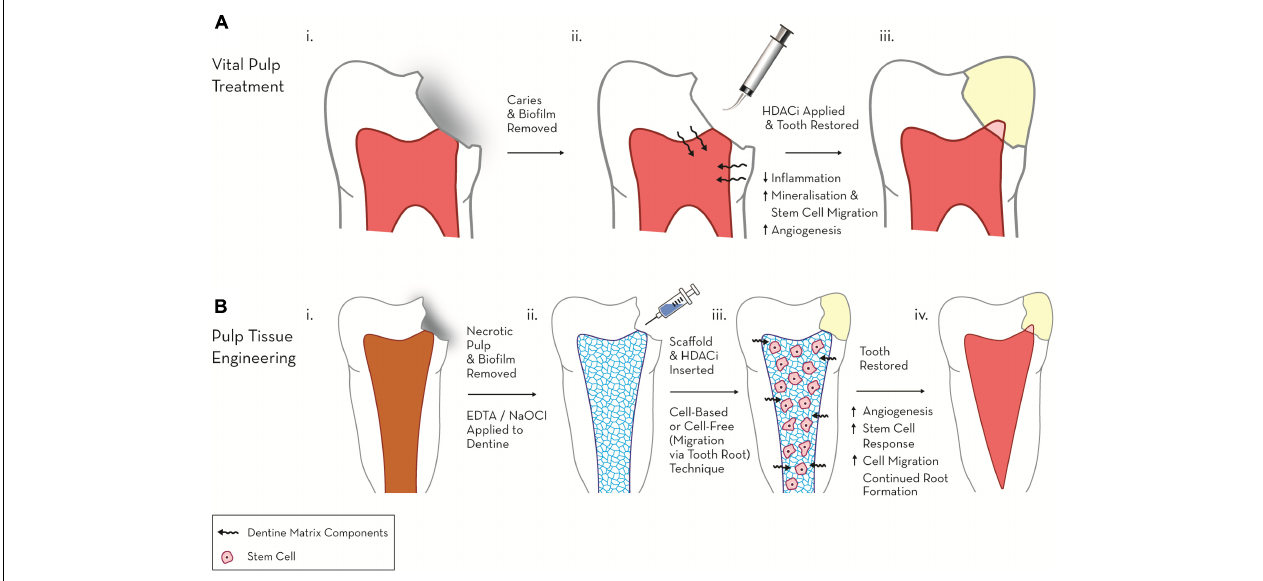
FIGURE 1 | Schematic diagram highlighting the therapeutic potential of HDACi in regenerative endodontics. (A) Vital pulp treatment. (i) Deep carious lesion exposes pulp tissue. (ii) HDACi topically applied to exposed pulp, potentially as a component of a dental restorative material [e.g., mineral trioxide aggregate (MTA), calcium hydroxide, resin-based composite (RBC)] promotes tissue-repair processes (mineralisation, modulated inflammation and cell migration). (iii) Tooth permanently restored with amalgam and mineralised bridge formation evident under dental pulp capping material. (B) Pulp tissue engineering. (i) Pulp necrosis (ii) Necrotic tooth chemo-mechanical debrided and EDTA, NaOCl applied to dentine to release matrix components. (iii) HDACi applied within a cell or non-cell based scaffold stimulates further growth factor release, cell migration and differentiation. (iv) Tooth restored and new pulp-like tissue formed promoting continued root growth and restoring tooth tissue